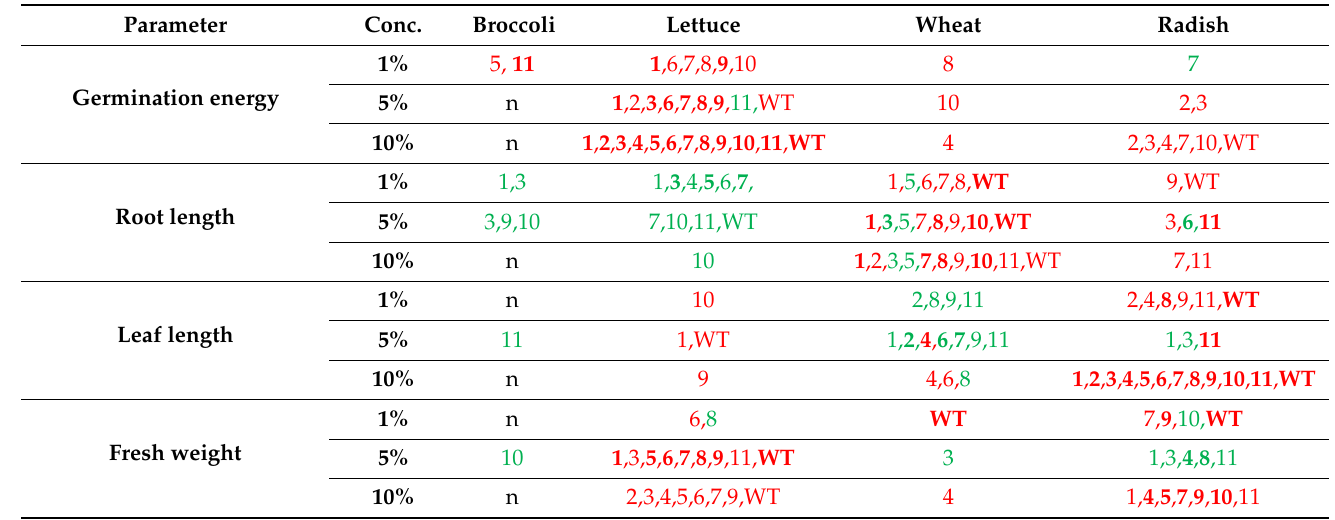
Table 2. Influence of different algal clones concentrations (conc.) on four tested parameters in four plant species. Each number represents the clone. In green are positive effects, and in red are negative effects. Neutral effects are represented by n. Significant effects are displayed in bold for *** p < 0.001 or **** p < 0.0001 or without bold for * p < 0.1 or ** p < 0.01. Parameter Conc. Broccoli Lettuce Wheat